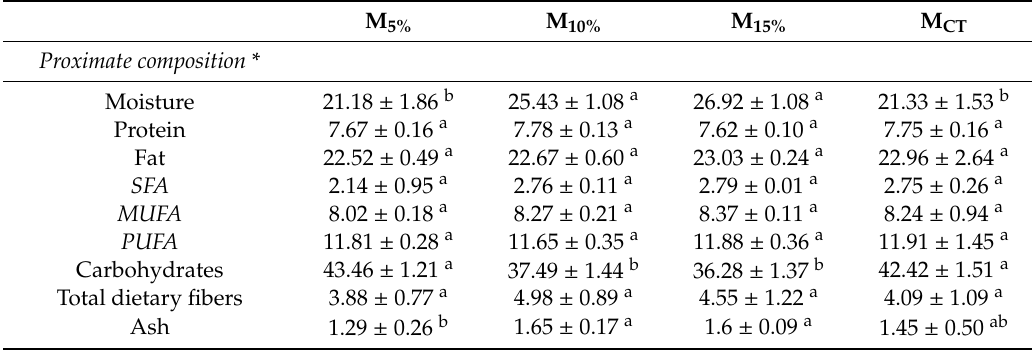
Table 1. Nutritional characterization of mu ffi ns: M 5% , mu ffi n containing 5% (wt / wt) type-I sourdough;